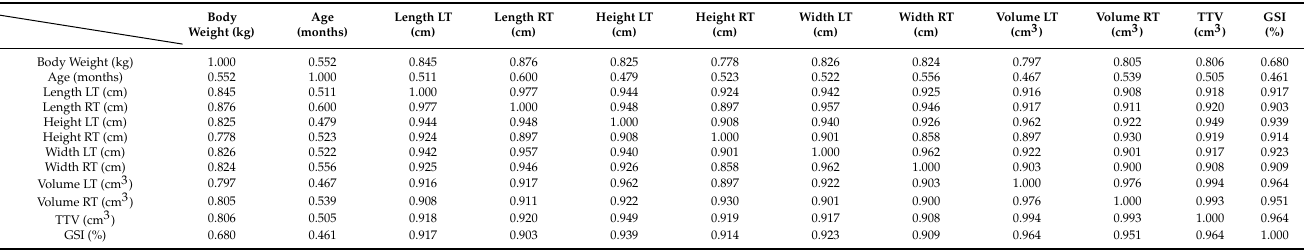
Table 3. Bayesian inference Pearson’s correlation output summary for BW (kg), age (months), US parameters, and composite indices.